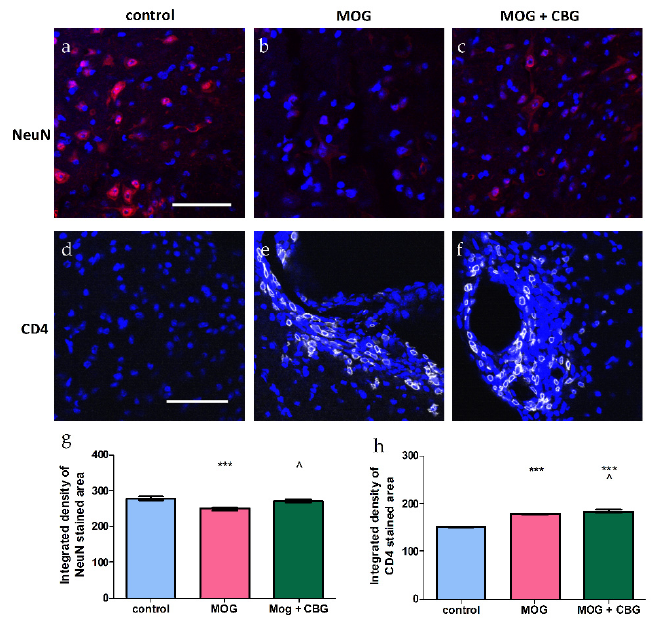
Figure 7. Immunohistochemistry of spinal cords of non-treated and EAE mice. Lumbar sections were stained with NeuN ( a – c ) (red) and CD4 ( d – f ) (white) and counterstained for nuclei with DAPI (blue). Representative lumbar layers from the mice groups are presented (n = 4–6 for each group). Immunodetections were quantified and plotted as integrated density for each antibody ( g , h ). One way ANOVA followed by a Tukey–Kramer multiple comparison test were performed to determine statistical significance. *** p < 0.001 vs. control; ^ p < 0.05 vs. MOG. The scale bar is 50 µm.